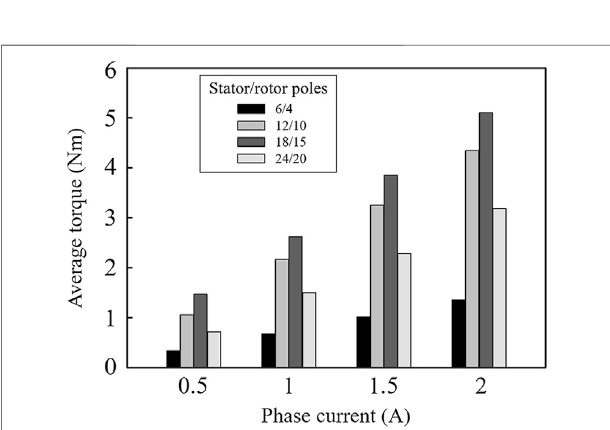
FIGURE 5 | The cogging torque waveforms of all proposed DSPM structures.